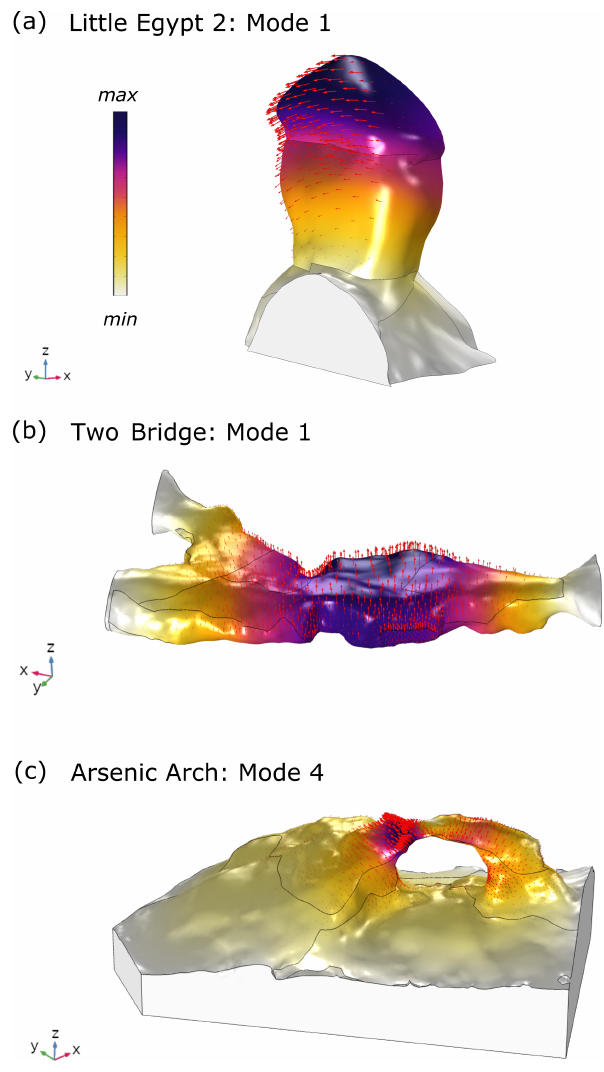
Figure B1. Example modeled mode shapes for Little Egypt 2 (a) , Two Bridge (b) , and Arsenic Arch (c)